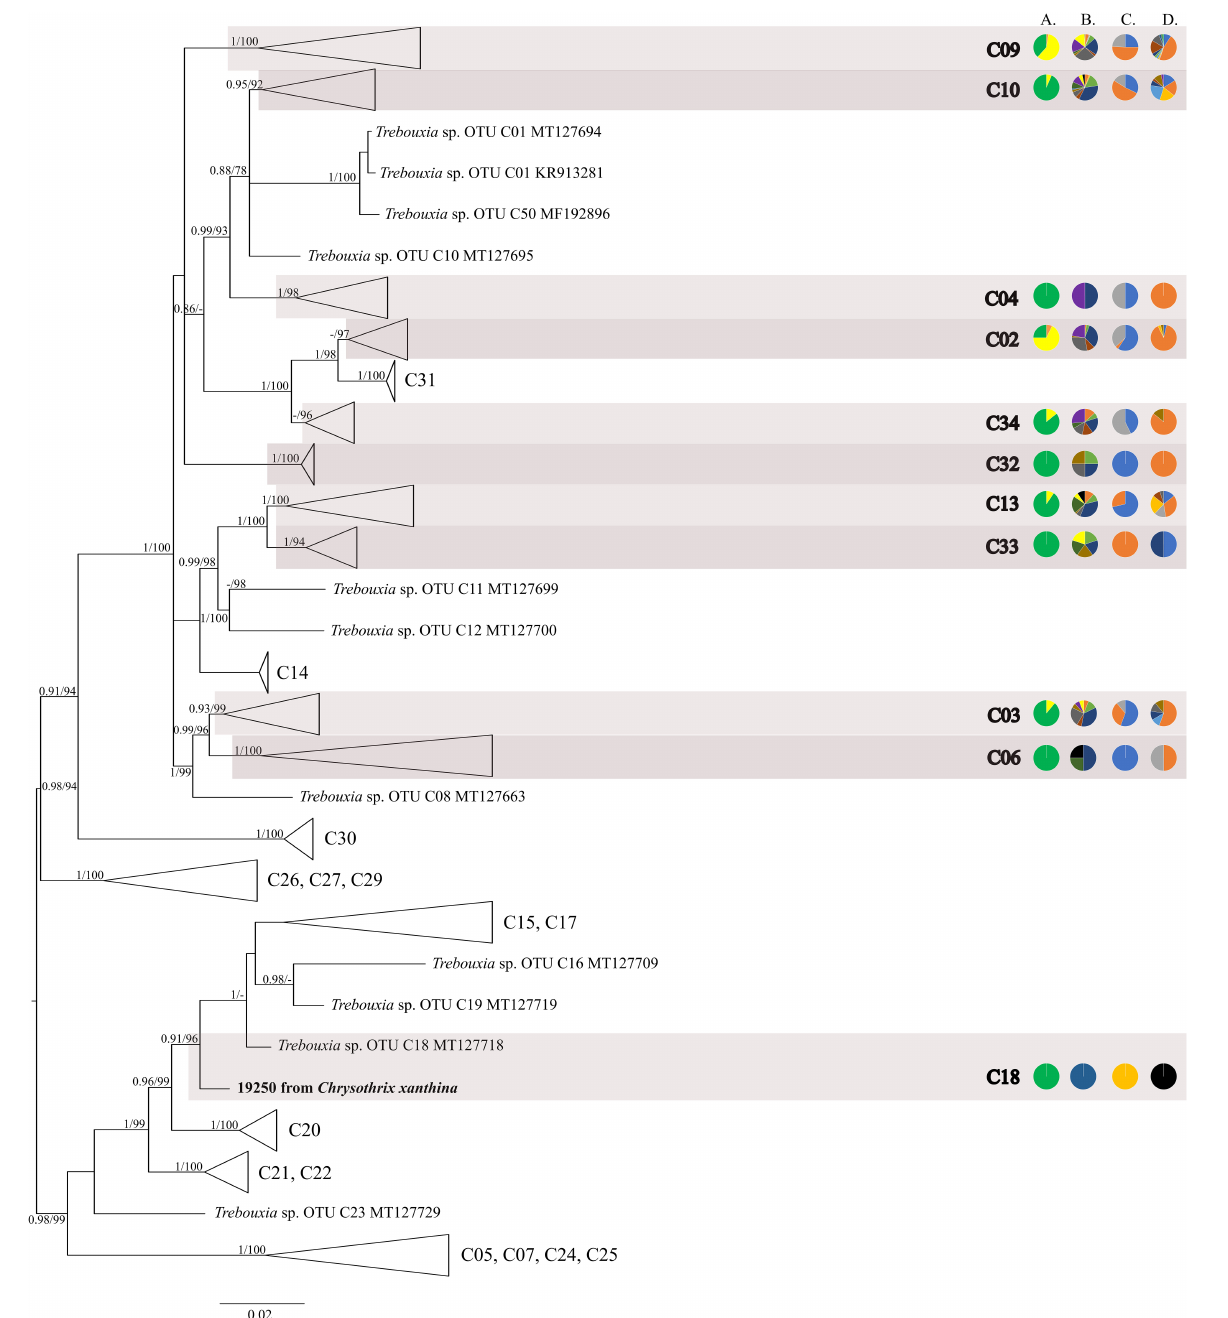
Frontiers in Microbiology |